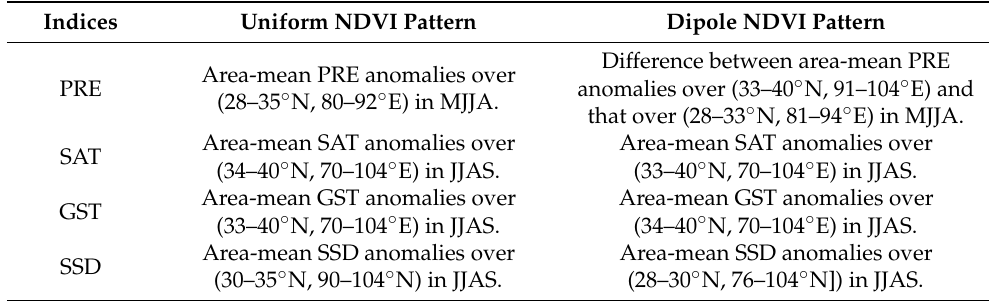
Table 1. Definition of the indices of the climate factors responsible for the uniform and dipole NDVI patterns and associated key regions.